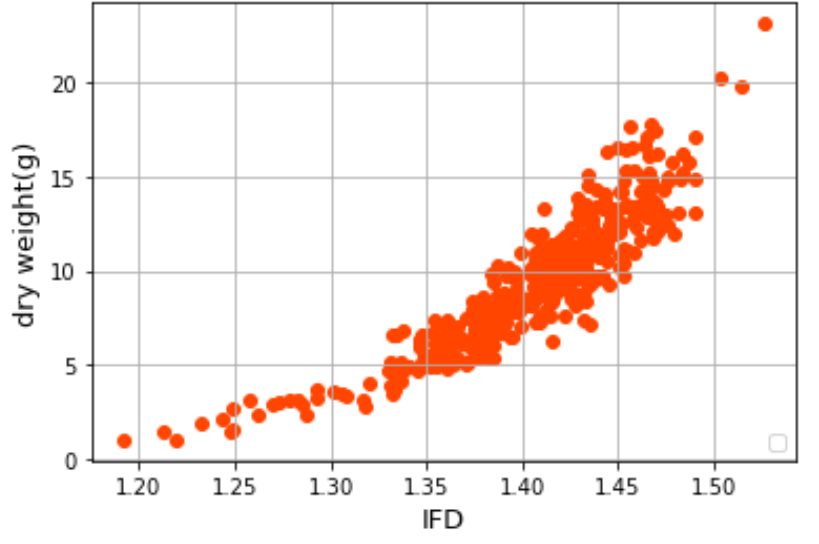
Figure 4. Scatter diagram of IFD and dry weight.